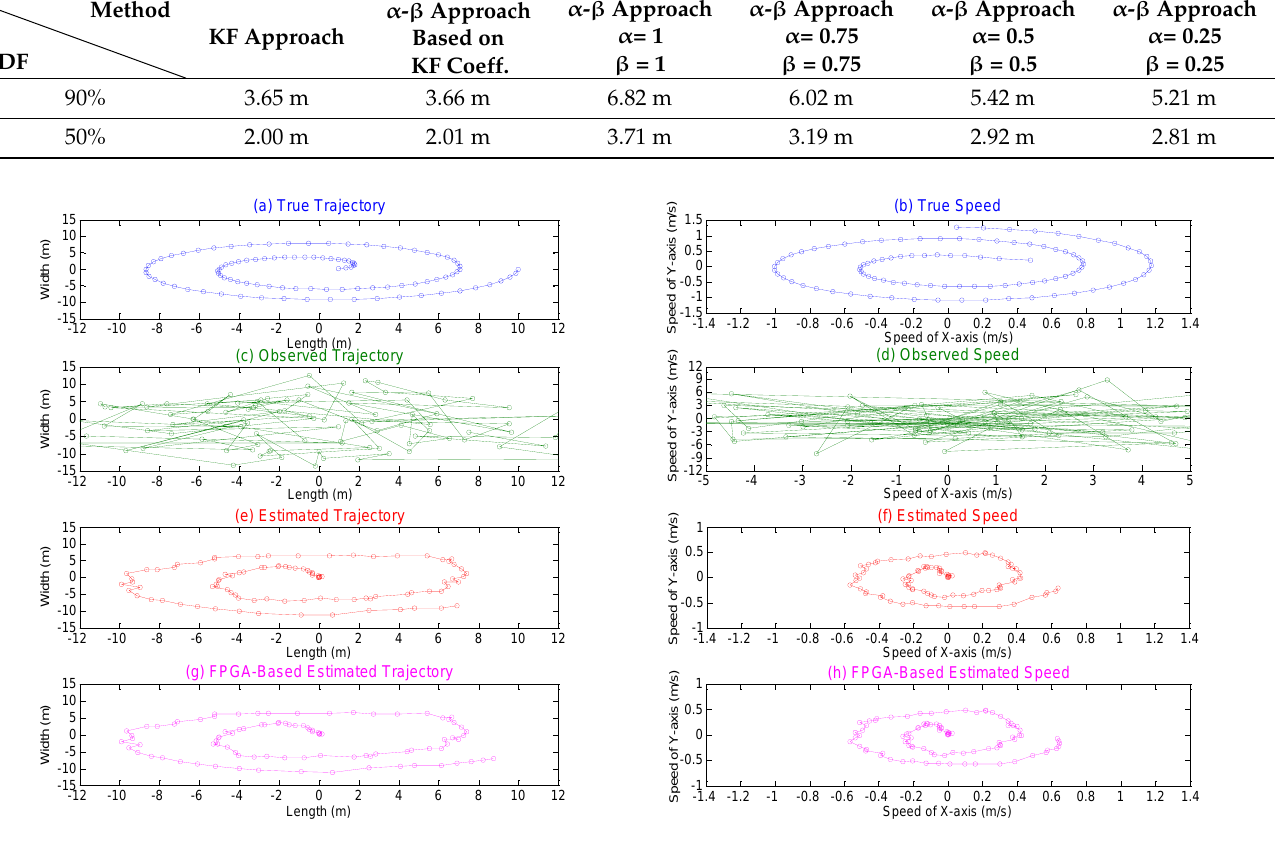
Figure 12. Software simulation and implement on hardware for the tracking location and speed of an MD based on α - β tracking approach as the MD moves the counterclockwise direction of the non-linear path in a plane of indoor environments ( a , b ) original trajectory and speed; ( c , d ) observed trajectory and speed (positioning approach); ( e , f ) estimated trajectory and speed; ( g , h ) FPGA-based estimated trajectory and speed.